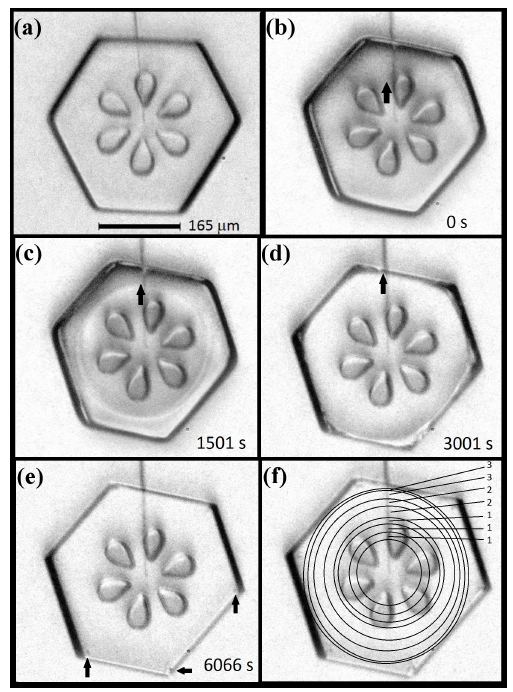
Figure 5. Expanding basal facet with corner-pocket formation. (a) Crystal just before sublimation. (b) – (e) Same crystal, during a second growth period at − 30 ◦ C and 1% supersaturation, just af- ter the sublimation period. The thick arrow marks a barely visible boundary of the basal facet, roughly forming a circle. In (c) , two such circles can be seen, representing the boundaries on both basal facets. The times of the images are in their bottom right corner. In (e) , arrows mark three corner pockets. (f) Same image as (e) , but with the estimated basal perimeters sketched with circles. Numbers on the right are the times between the perimeter sketches in units of 5min. Data are plotted in Fig.